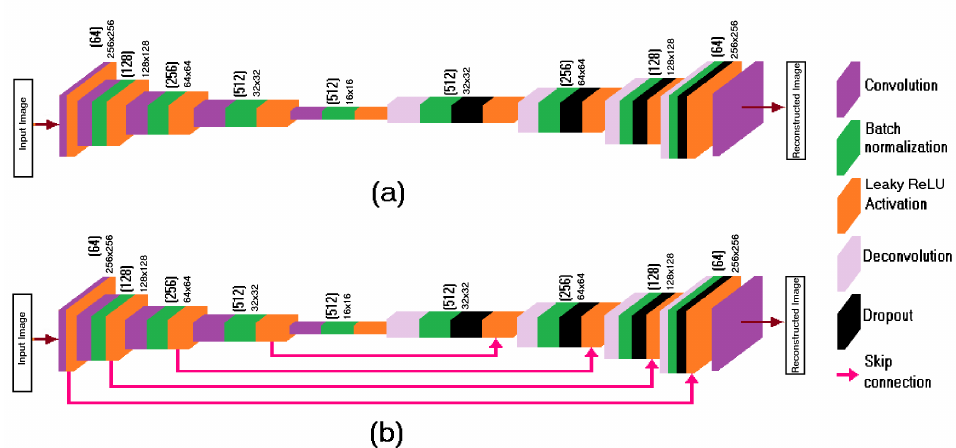
Figure 3. Two reconstruction networks: ( a ) convolutional autoencoder (ConvAE) and ( b ) ConvAE with skip connection